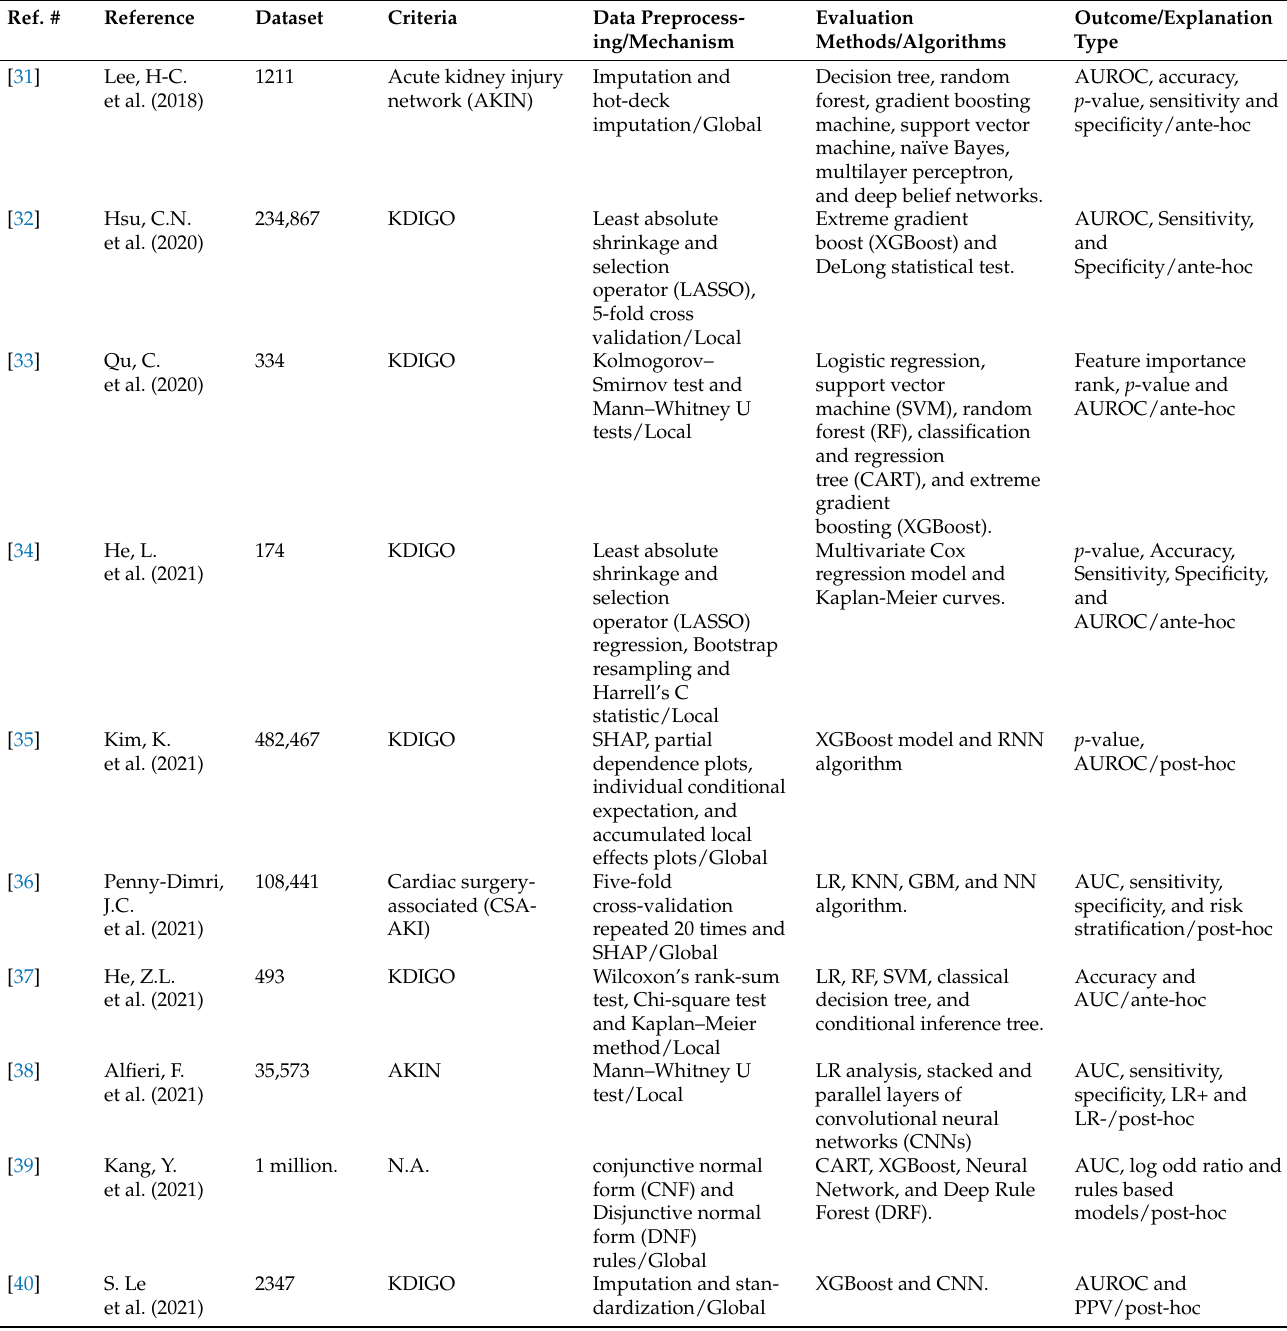
Table 3. Analysis for the AKI-affected patients treatment